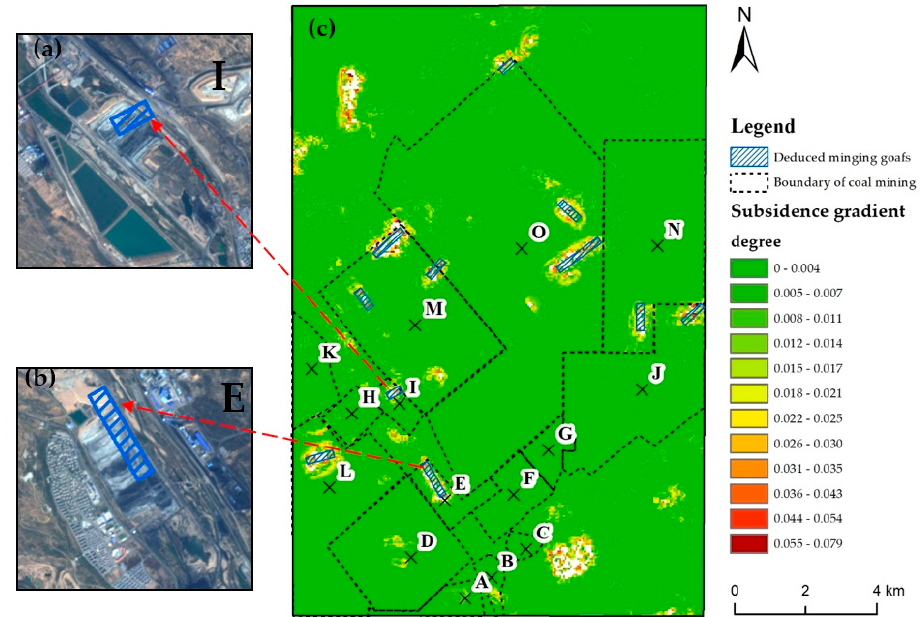
Figure 9. ( a , b ) The corresponding SPOT-6 images with respect to the deduced goaf boundaries in E and I coal mines; ( c ) the deduced boundaries of mining goafs from 2014 to 2015 (blue lines) superimposed on the subsidence gradient map.